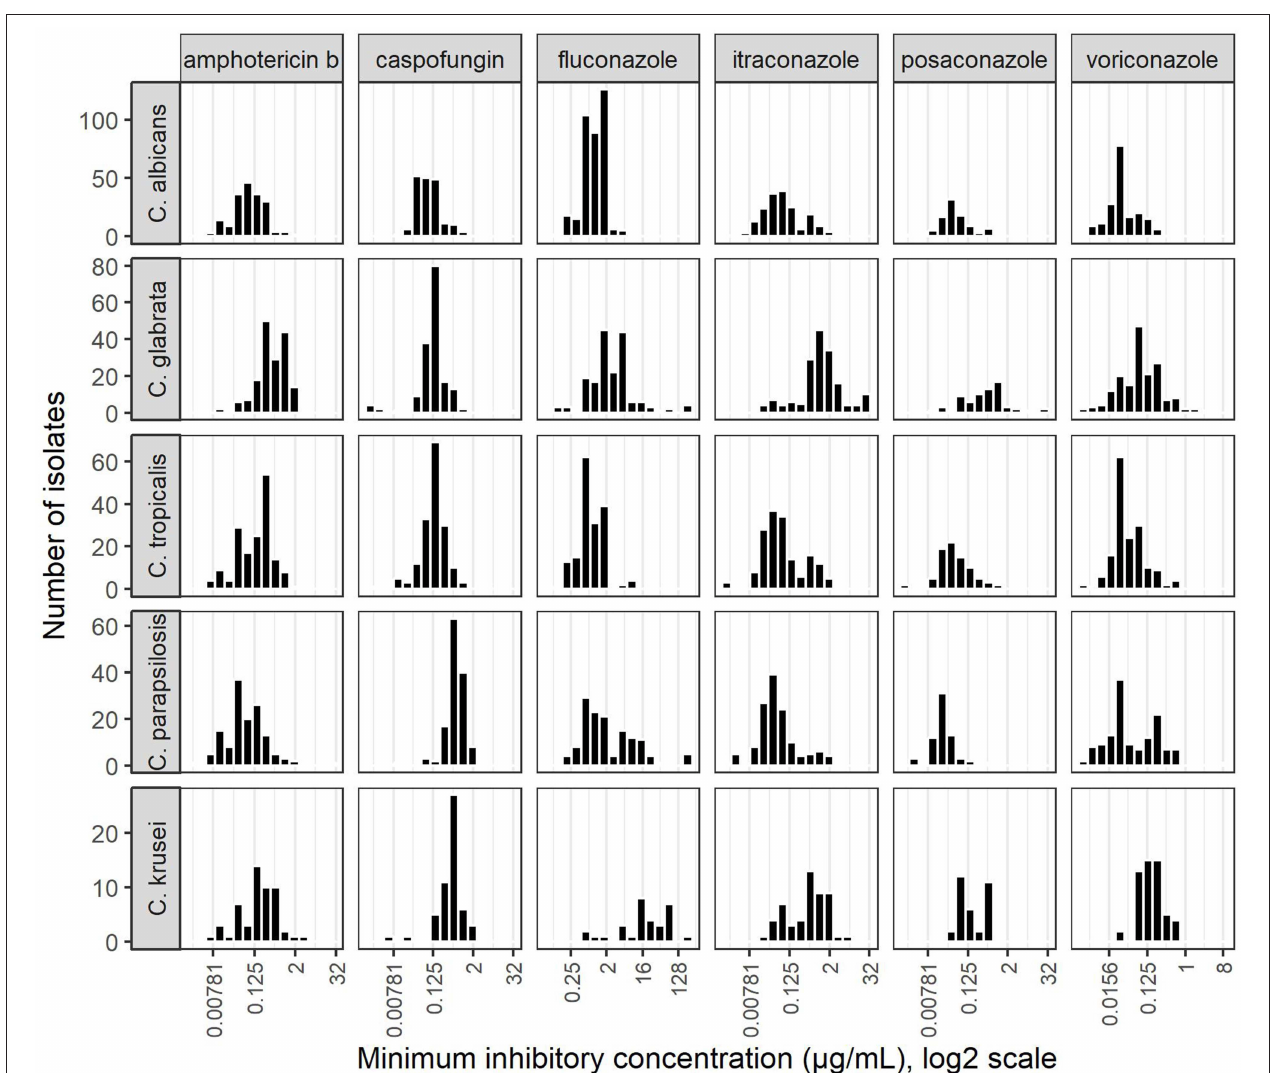
FIGURE 3 | Minimal inhibitory concentration distributions of antifungals against Candida